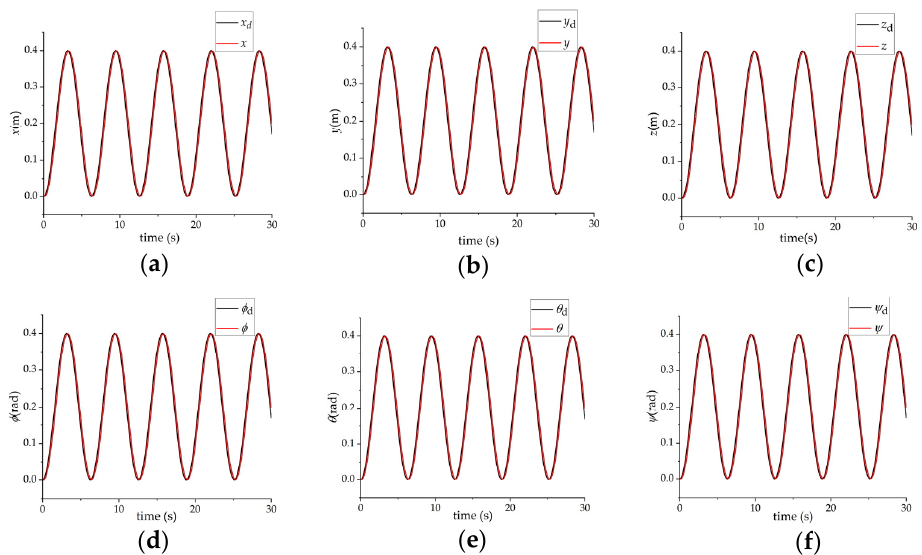
Figure 7. The pose following at the end effector of the robot. ( a ) the x component, ( b ) the y component, ( c ) the z component, ( d ) the φ component, ( e ) the θ component, and ( f ) the ψ component. Figure 7 shows that the robot’s end effector can better follow the given position of the VR handle while the system is in a stable state. (cid:0) (cid:1) M x , M y , M z , F x , F y , F z The output of the virtual force sensor FFF p1 = during this process is shown in Figure 8.